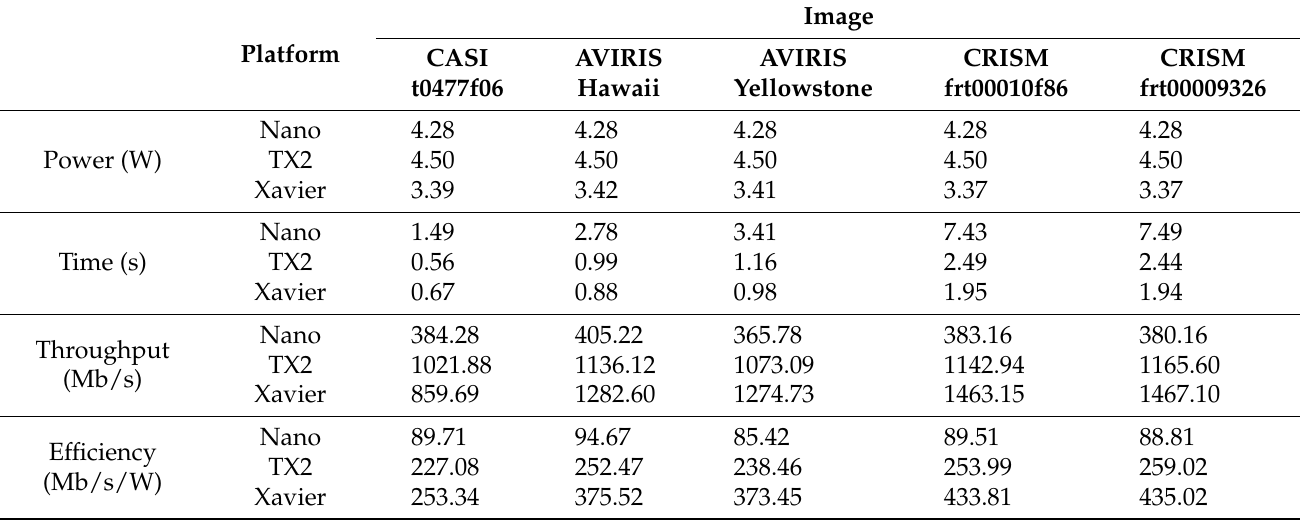
Table 6. Overall performance for the tested images using the parallel predictor and block adaptive entropy encoder in low power modes.